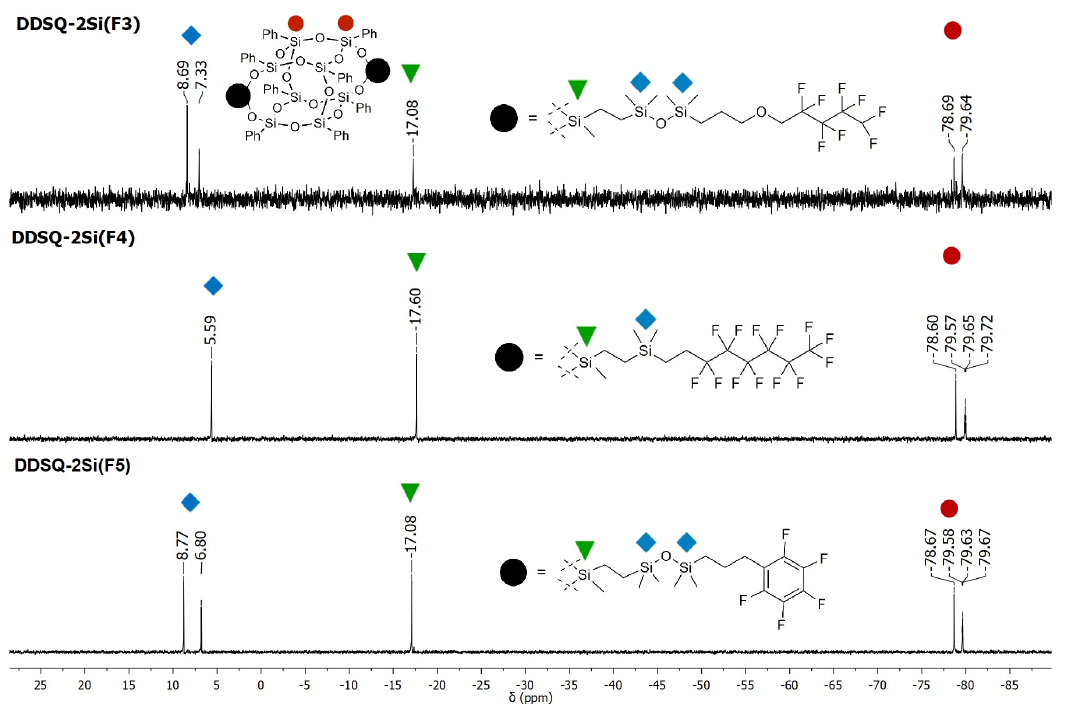
Figure 4. Selected range of stacked 29 Si-NMR spectra of DDSQ-2Si(F3) , DDSQ-2Si(F4) and DDSQ-2Si(F5) .